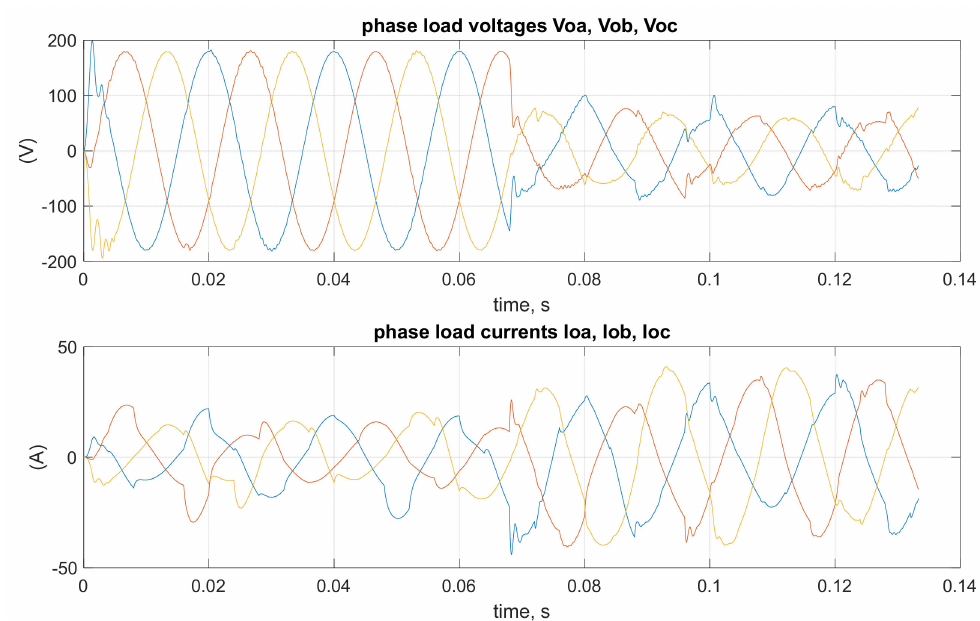
Figure 18. Waveforms of load voltage V o and the distorted load current of the I o in the dq coordinate system with substantial limitations on I r and V r and with a steep increase in load for the time of 0.068 s, where the load increase results in the decrease and deformation of the voltage V o .